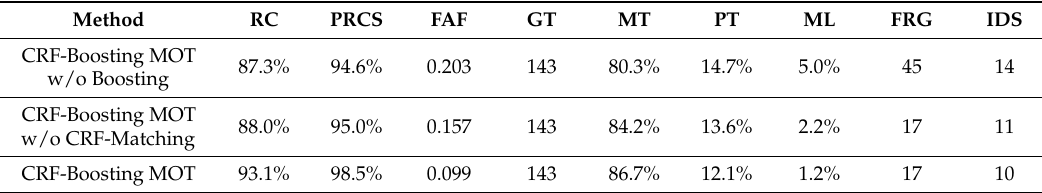
Table 6. Effects of CRF Matching and Online Hybrid Boosting.